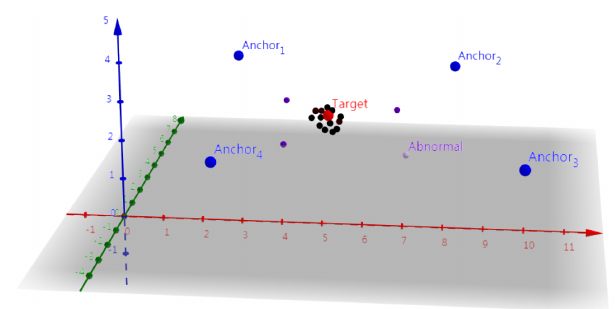
Figure 2. Schematic diagram of the target location results to be measured.